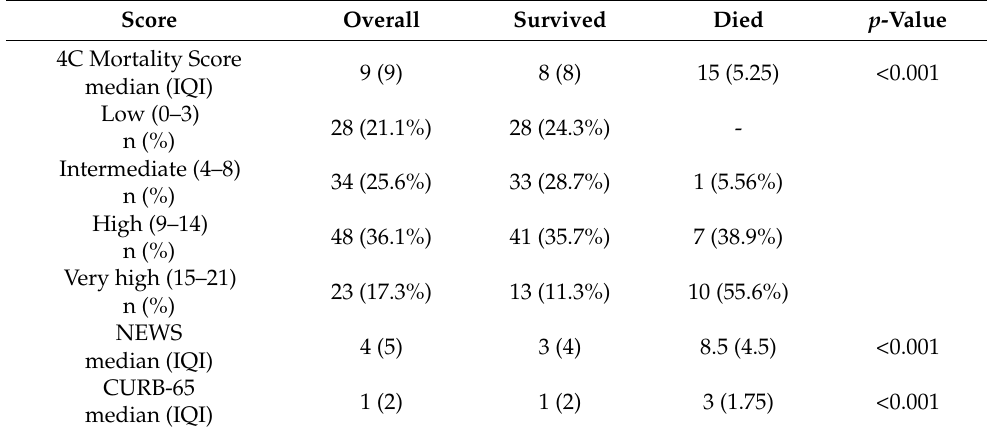
Table 2. Comparison of 4C Mortality, NEWS, and CURB-65 scores.